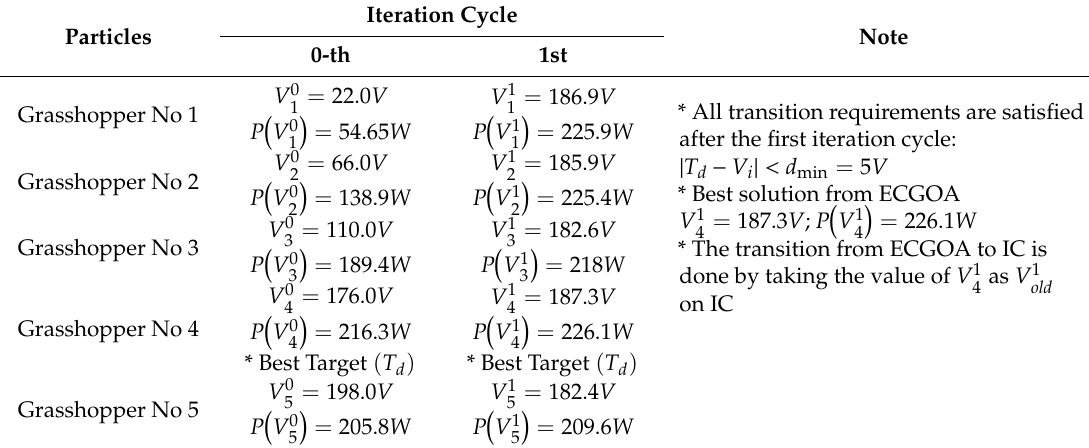
Table 2. Tracking steps details using IC.